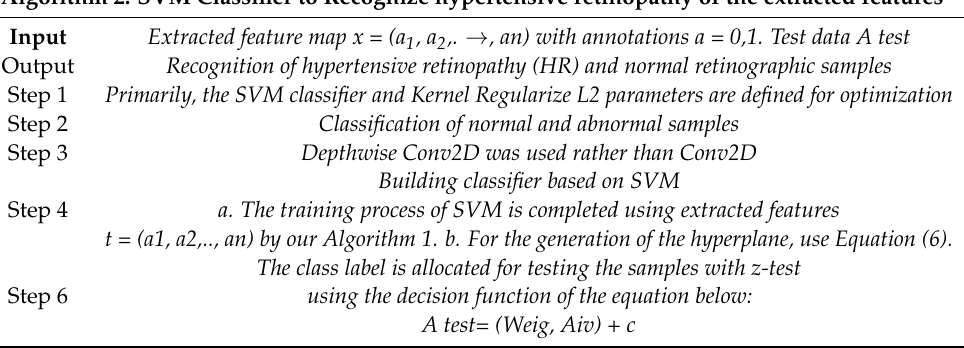
Algorithm 2: SVM Classifier to Recognize hypertensive retinopathy of the extracted features